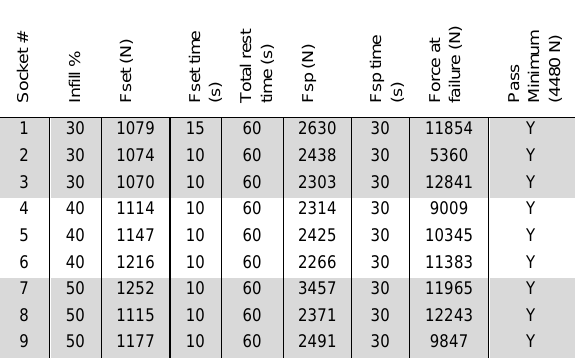
Figure 4. Left: Tinius Olsen Universal Testing Apparatus; Right: Completed Table 2. Results of Loading Procedure (Note: Fset = Settling test force, Fsp = Static proof test force).